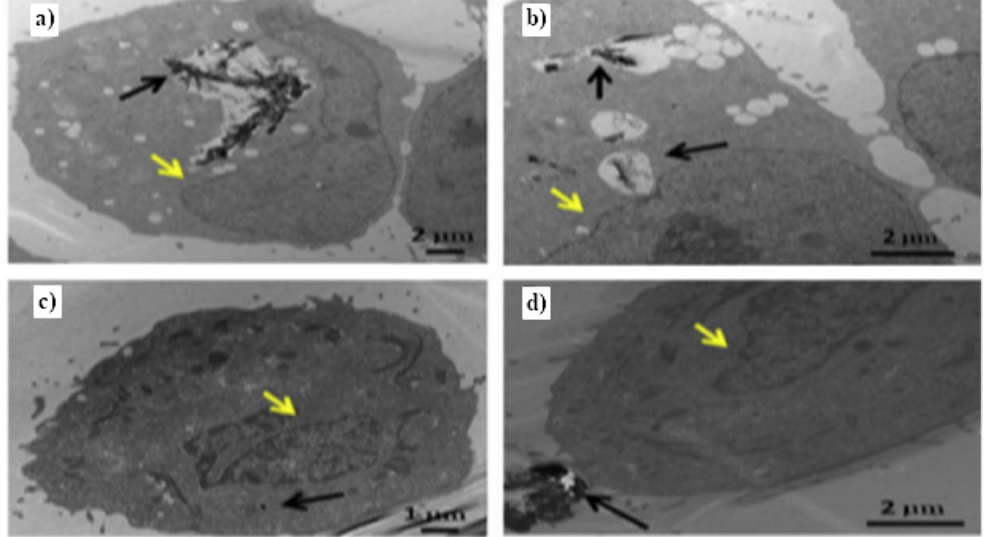
Figure 8. ( a ) The uptake of GONR–PEG–DSPE into U251 cells in large vesicular structures (black arrow); ( b ) the uptake of small aggregates of GONR–PEG–DSPE into U251 cells (black arrow); ( c ) no or minimal uptake of GONR–PEG–DSPE into MCF-7 cells (black arrow); ( d ) large aggregates